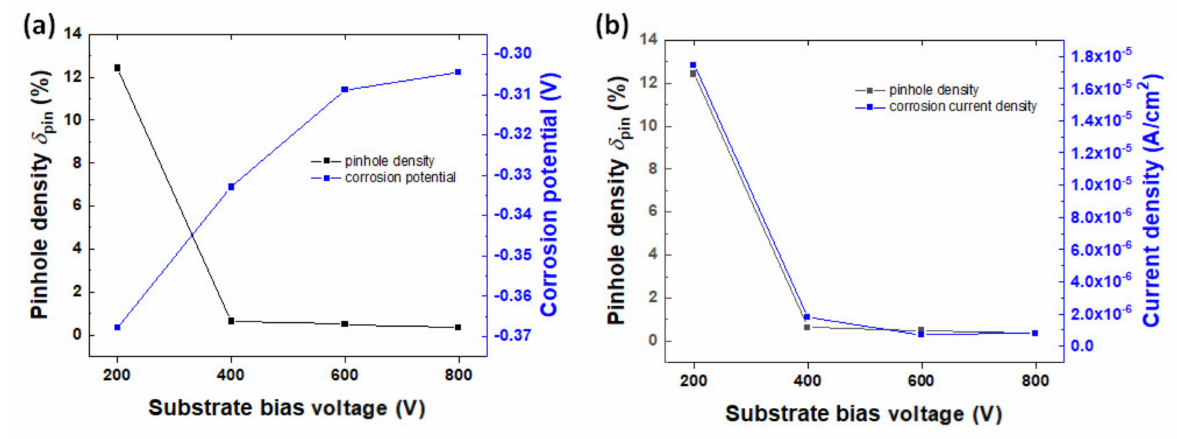
Figure 4. The effect of pinhole density variation on the corrosion ( a ) potential and ( b ) current density.